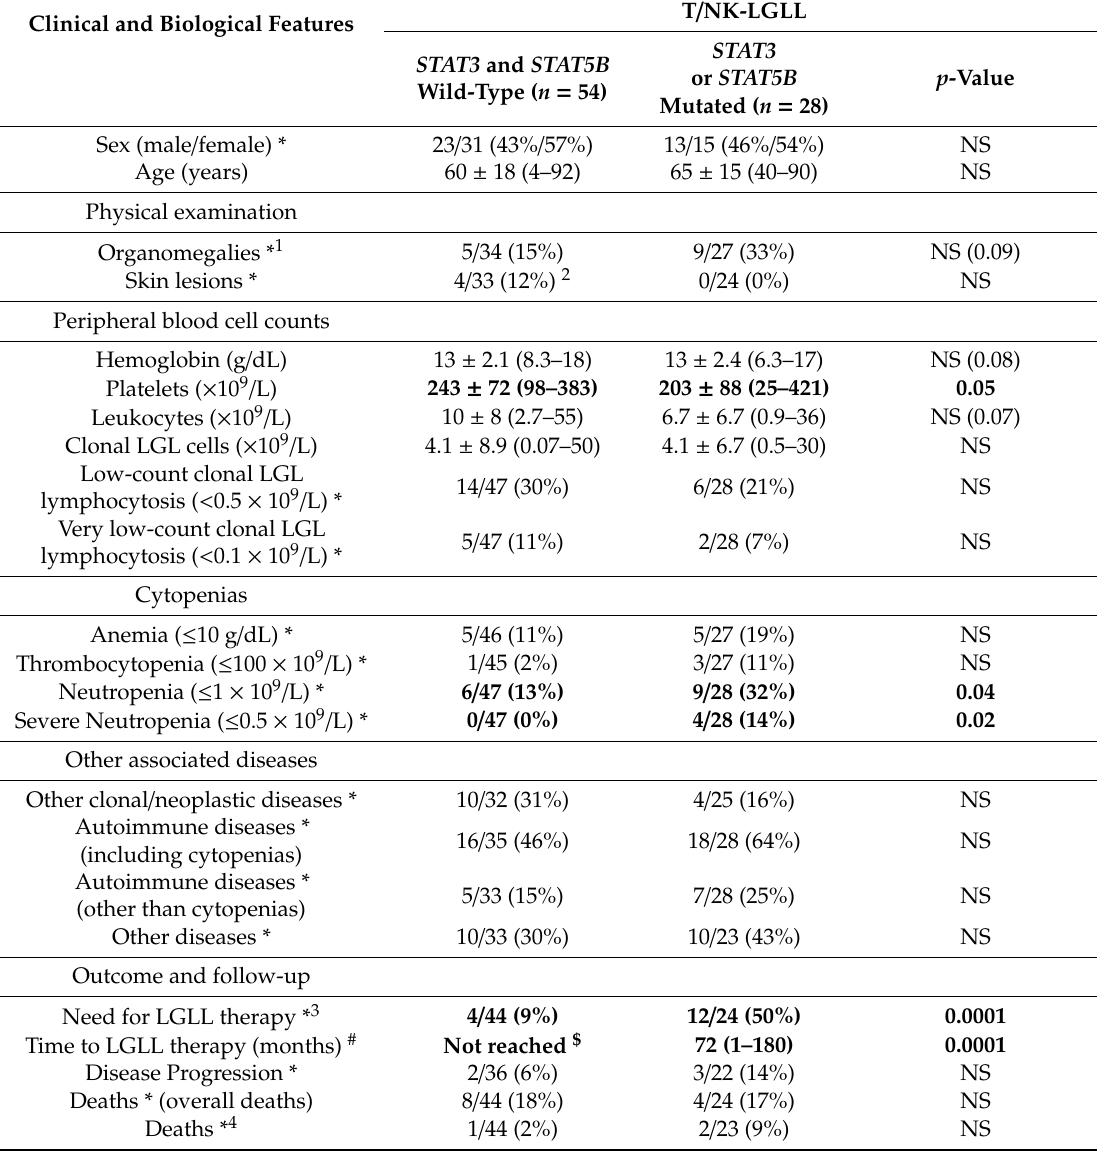
Table 3. Clinical and biological features of clonal T / NK-LGLL patients ( n = 82) distributed according to their STAT3 or STAT5B mutational